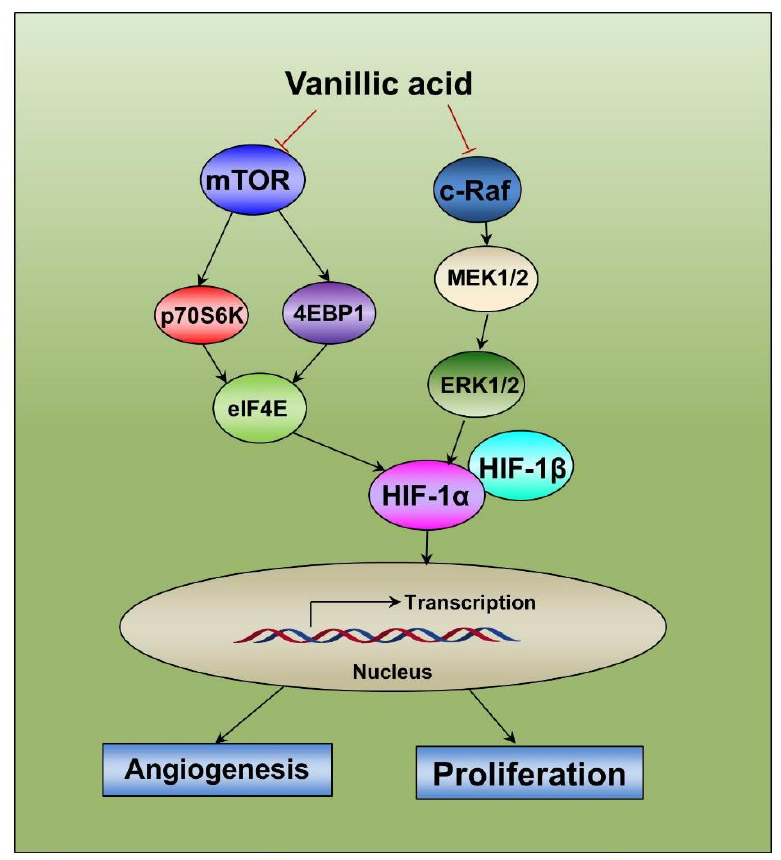
Figure 8. Diagram of the proposed mechanism by which vanillic acid (Van) inhibits proliferation and angiogenesis. The anti-proliferation and anti-angiogenesis effect of vanillic acid (Van) occurs mainly through the downregulation of HIF-1 α by the inhibition of the mTOR/p70S6K/4E-BP1 and Raf/MEK/ERK signaling pathways. This study indicates that HIF-1 α can be a potential anti-cancer target for vanillic acid (Van).